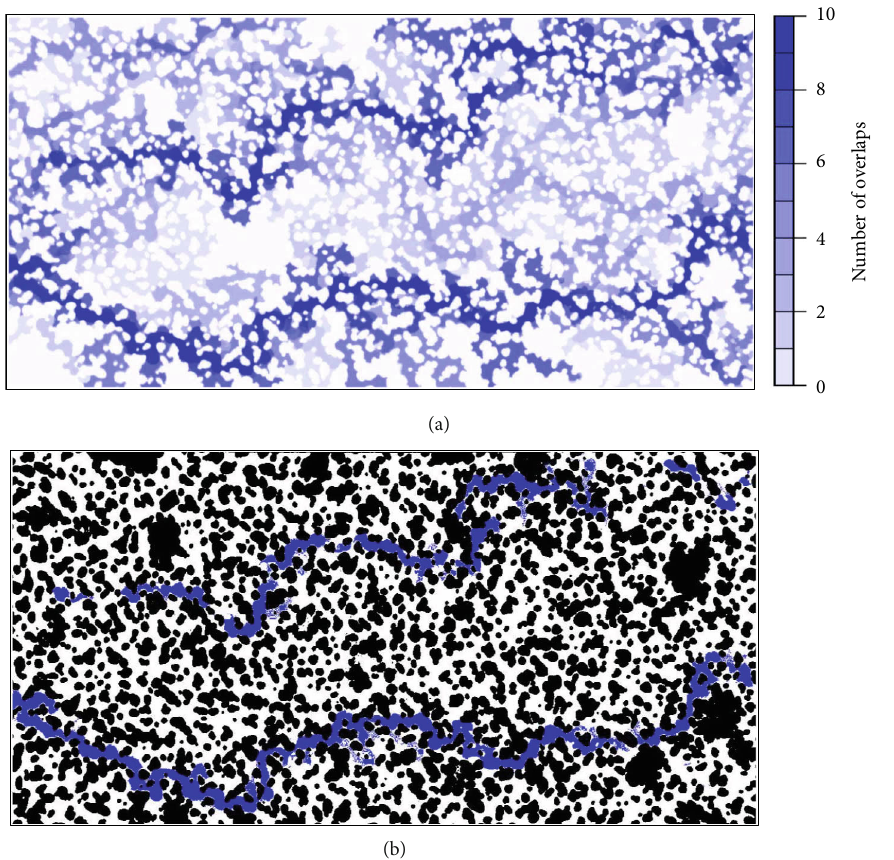
Figure 11: Images for fl ow channels in a micromodel: (a) overlapped image of fl ow channels formed over the course of fi ve sets of drainage- imbibition cycles. The di ff erence of the color indicates the number of overlapped fl ow channels, (b) main fl ow channels ( number of overlaps > 9 ) plotted on binary image of the